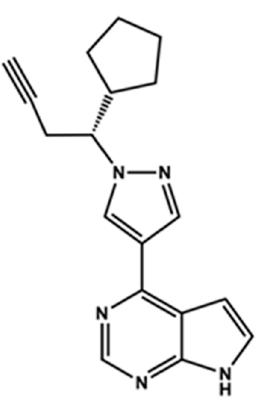
Figure 1. Structure of ruxolitinib, (3 R )-3-cyclopentyl-3-[4-(7H-pyrrolo[2,3-d]pyrimidin-4-yl)pyrazol- l-yI]propanenitrile.